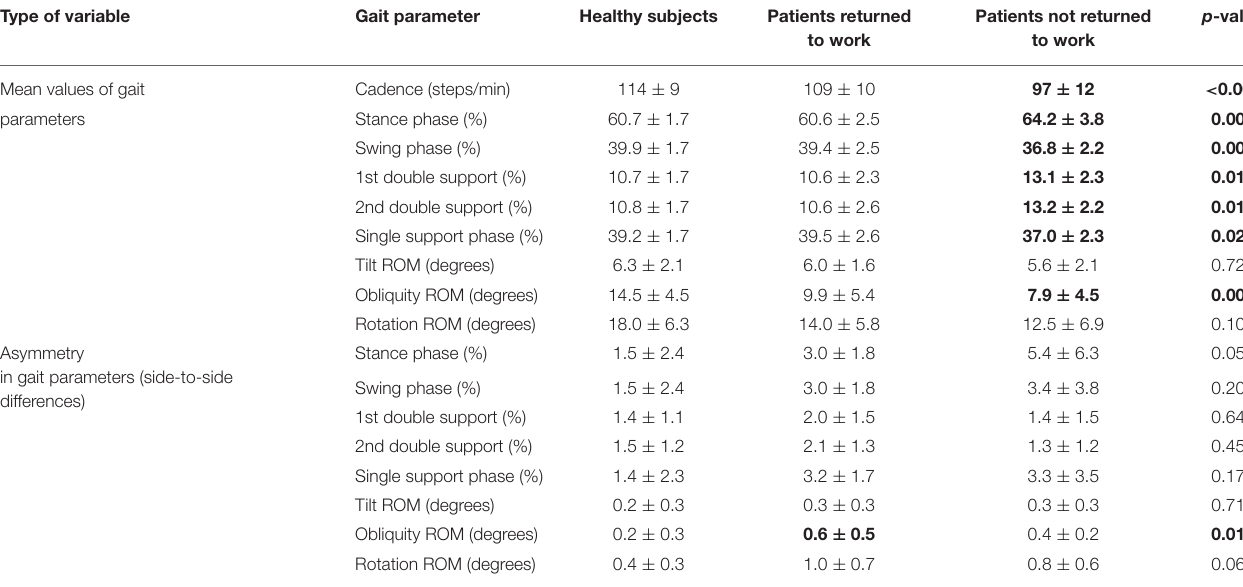
TABLE 1 | Means ± standard deviations of gait parameters estimated by the inertial measurement unit for healthy subjects, patients who returned to work and patients unable to return to work. Type of